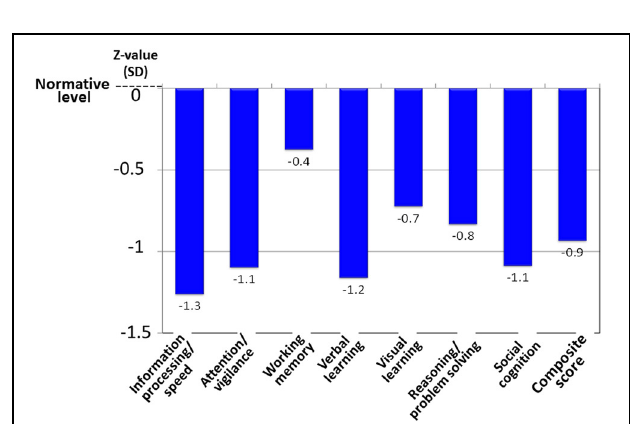
FIGURE 6 | Cognitive impairment of schizophrenia, as evaluated by the MATRICS Consensus Cognitive Battery–Japanese version. Patients with schizophrenia ( N = 30) demonstrate about a one-standard deviation decline from the normative value in the performance on tests of several cognitive domains. Data were obtained from Outpatient Clinic of University of Toyama